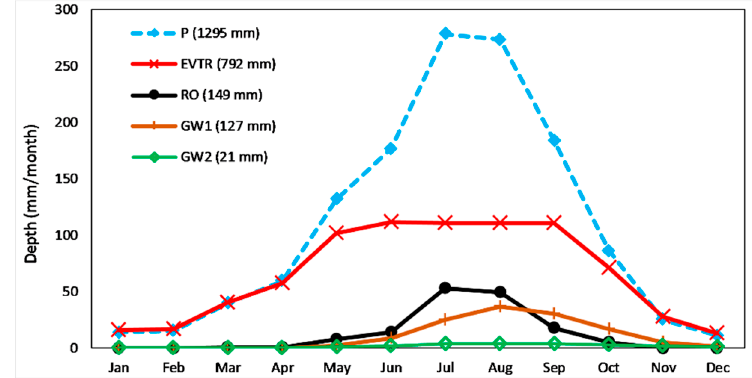
Figure 12. Average monthly mass balance (before transformation to hydrographs at the outlet).